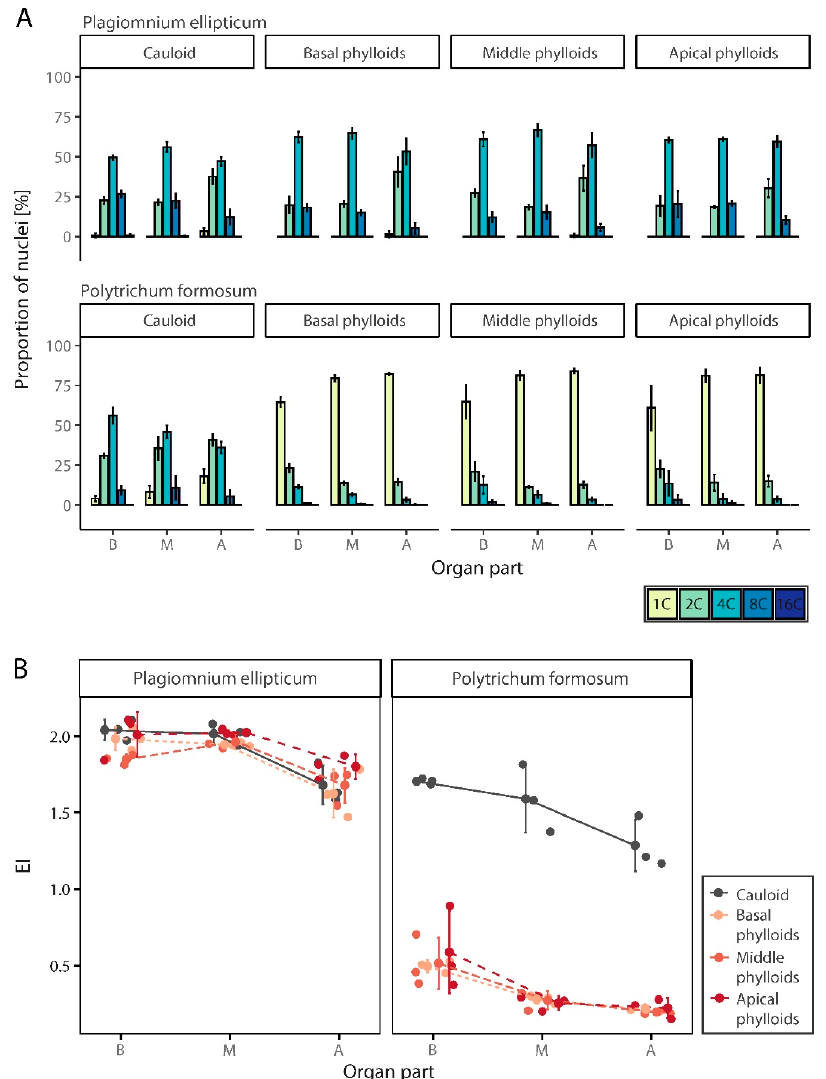
Figure 6. Spatial endopolyploidy pattern in naturally growing moss species, Plagiomnium ellipticum and Polytrichum formosum . ( A ) Percentual distribution (mean ± SD) of different categories of nuclei isolated from separated organ and organ parts of two moss species. ( B ) Jitter plot with mean ± SD for endoreduplication index (EI) values of studied moss species, their organs and organ parts. B, basal part of an organ; M, middle part of an organ; A, apical part of an organ.